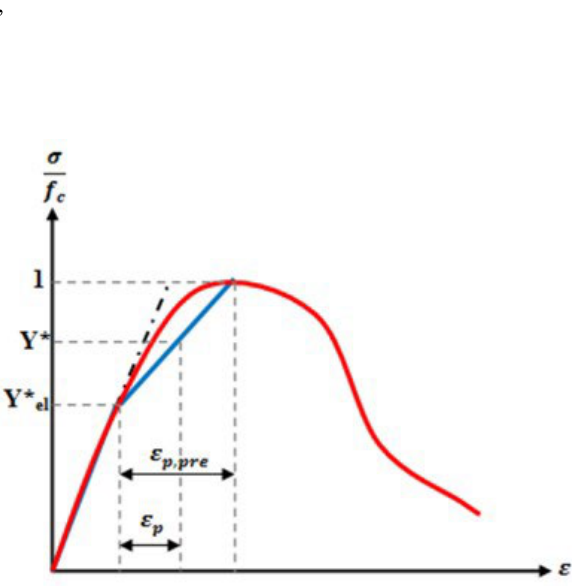
Figure 6- Concept of strain hardening in RHT concrete